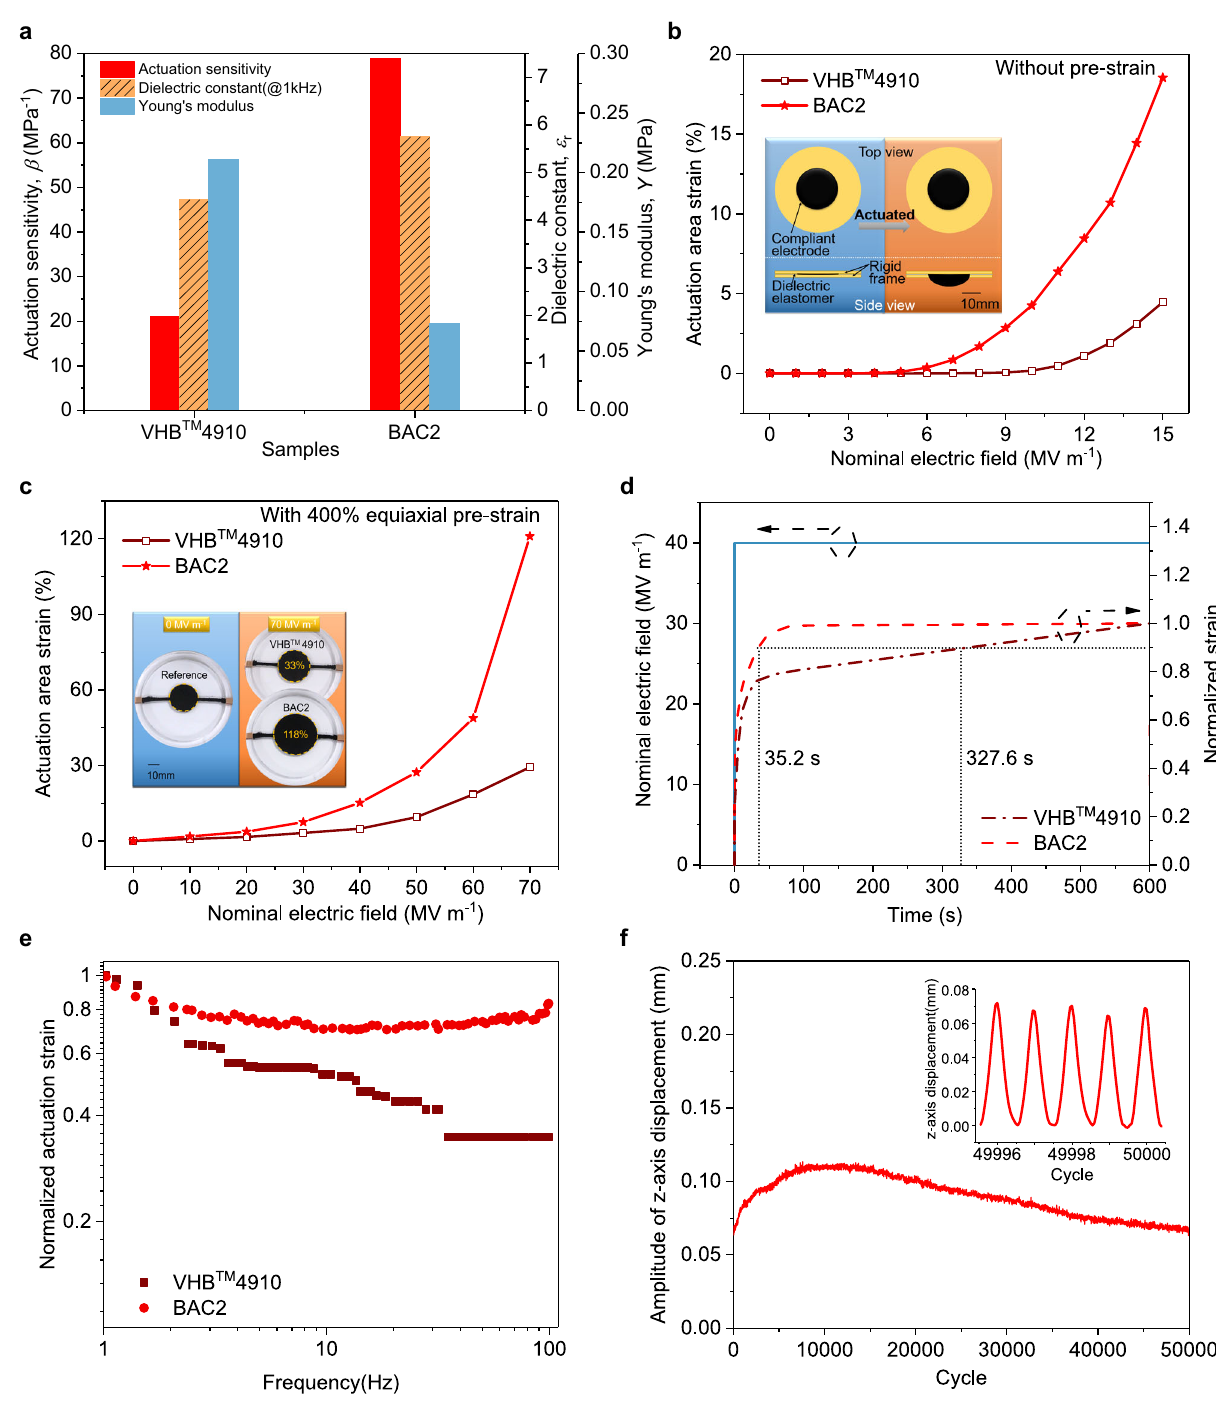
Fig. 3 Actuation performance. a Comparison of dielectric constant ( ε r ) measured at 1 kHz, Young ’ s modulus ( Y ), and actuation sensitivity ( β ) between VHB TM 4910 and BAC2 sample. b Dependence of actuation area strain on the nominal electric fi eld for the fi lms of VHB TM 4910 and BAC2 elastomers without pre-strain. The nominal electric fi eld is de fi ned as voltage on fi lms divided by initial thickness before electrically actuated. The inset shows the schematic diagrams illustrating the electro-actuation deformation process from the view of top and side directions. c Dependence of actuation area strain on the nominal electric fi eld for the fi lms of VHB TM 4910 and BAC2 elastomers with 400% equiaxial pre-strain. The inset displays the optical images of VHB TM 4910 and BAC2 fi lms before and after actuated. d Time-dependent behavior of the actuated area strain of VHB TM 4910 and BAC2 fi lms with 400% equiaxial pre-strain at 40 MV m − 1 . Normalized strain denotes the time-varying strain divided by strain at 600 s. e Frequency response of samples to large drive signals (5 kV) in the range of 1 – 100 Hz. The data were normalized to 1 at 1 Hz. f Cyclic actuation test of 50,000 cycles was performed on BAC2 fi lm at electric fi eld of 5 kV and excitation frequency of 5 Hz. The inset demonstrated z -axis displacement response in the last fi ve